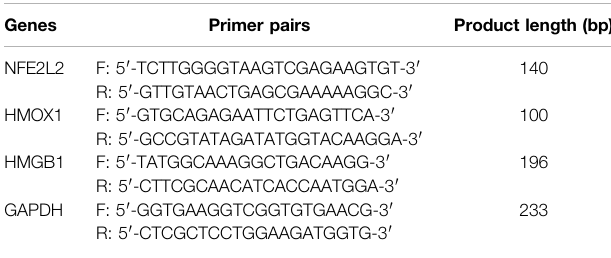
TABLE 3 | RT-PCR primer sequences.